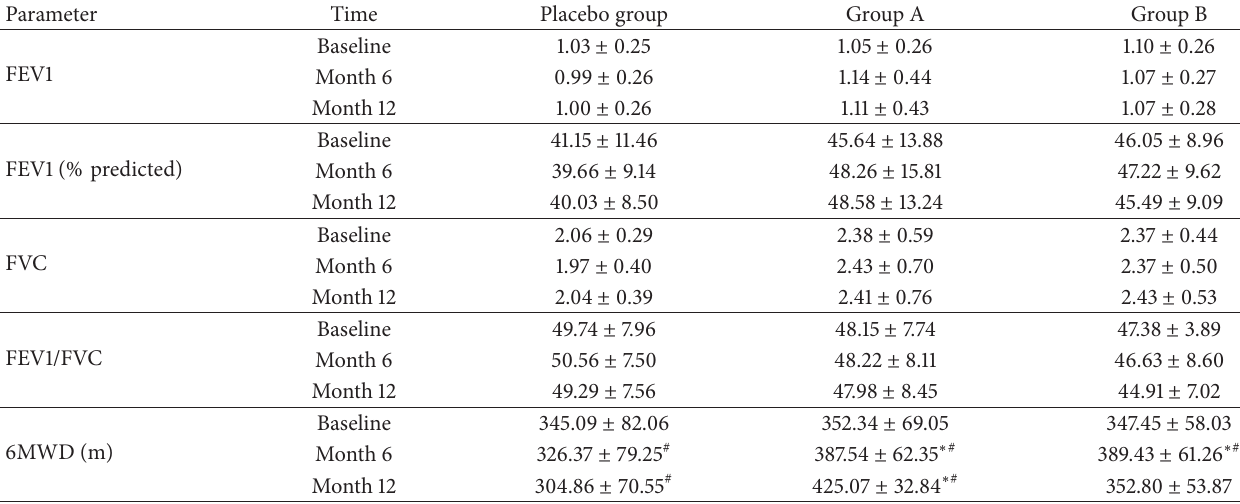
The mean ± standard deviation values are shown. Some pulmonary function indices including the forced expiratory volume in 1 second (FEV1), FEV1 ( % predicted), FEV1/forced vital capacity (FVC), FVC, and the 6-minute walk distance (6MWD) are shown. Compared to the placebo treatment, ∗ 𝑃 value < .05; compared to baseline, # 𝑃 value <